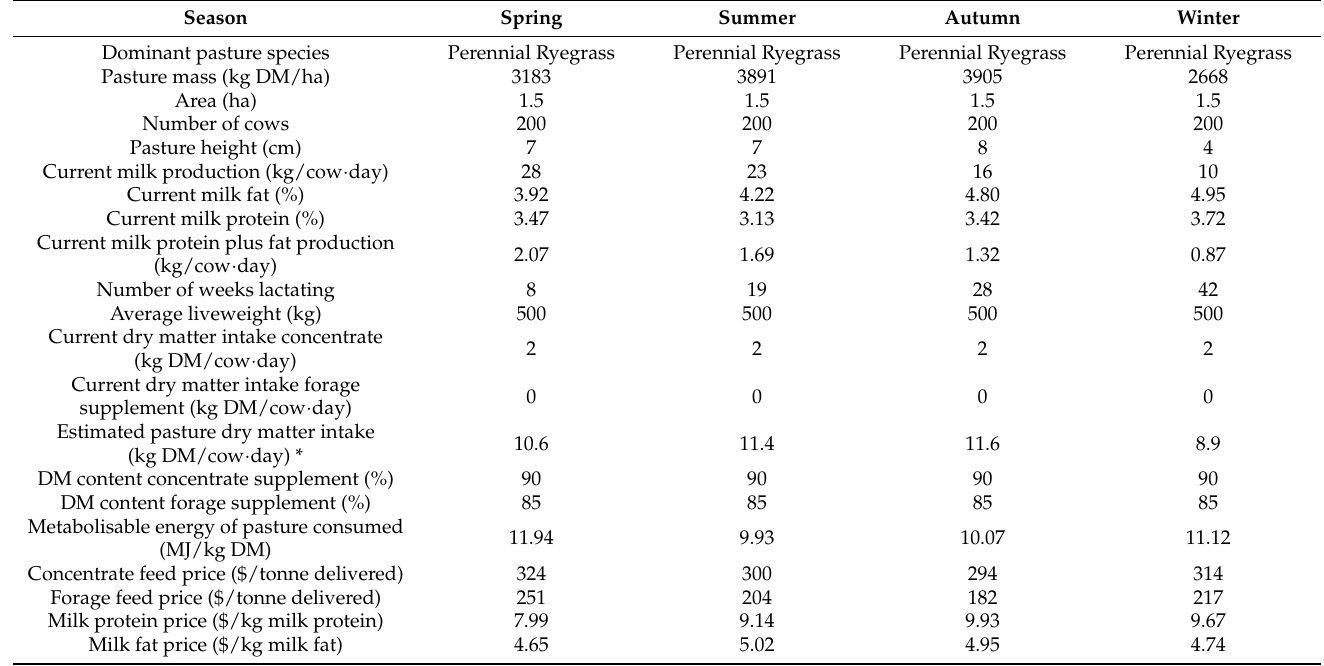
Table 3. Input data used to demonstrate milk response functions to concentrate and pasture + forage intake.